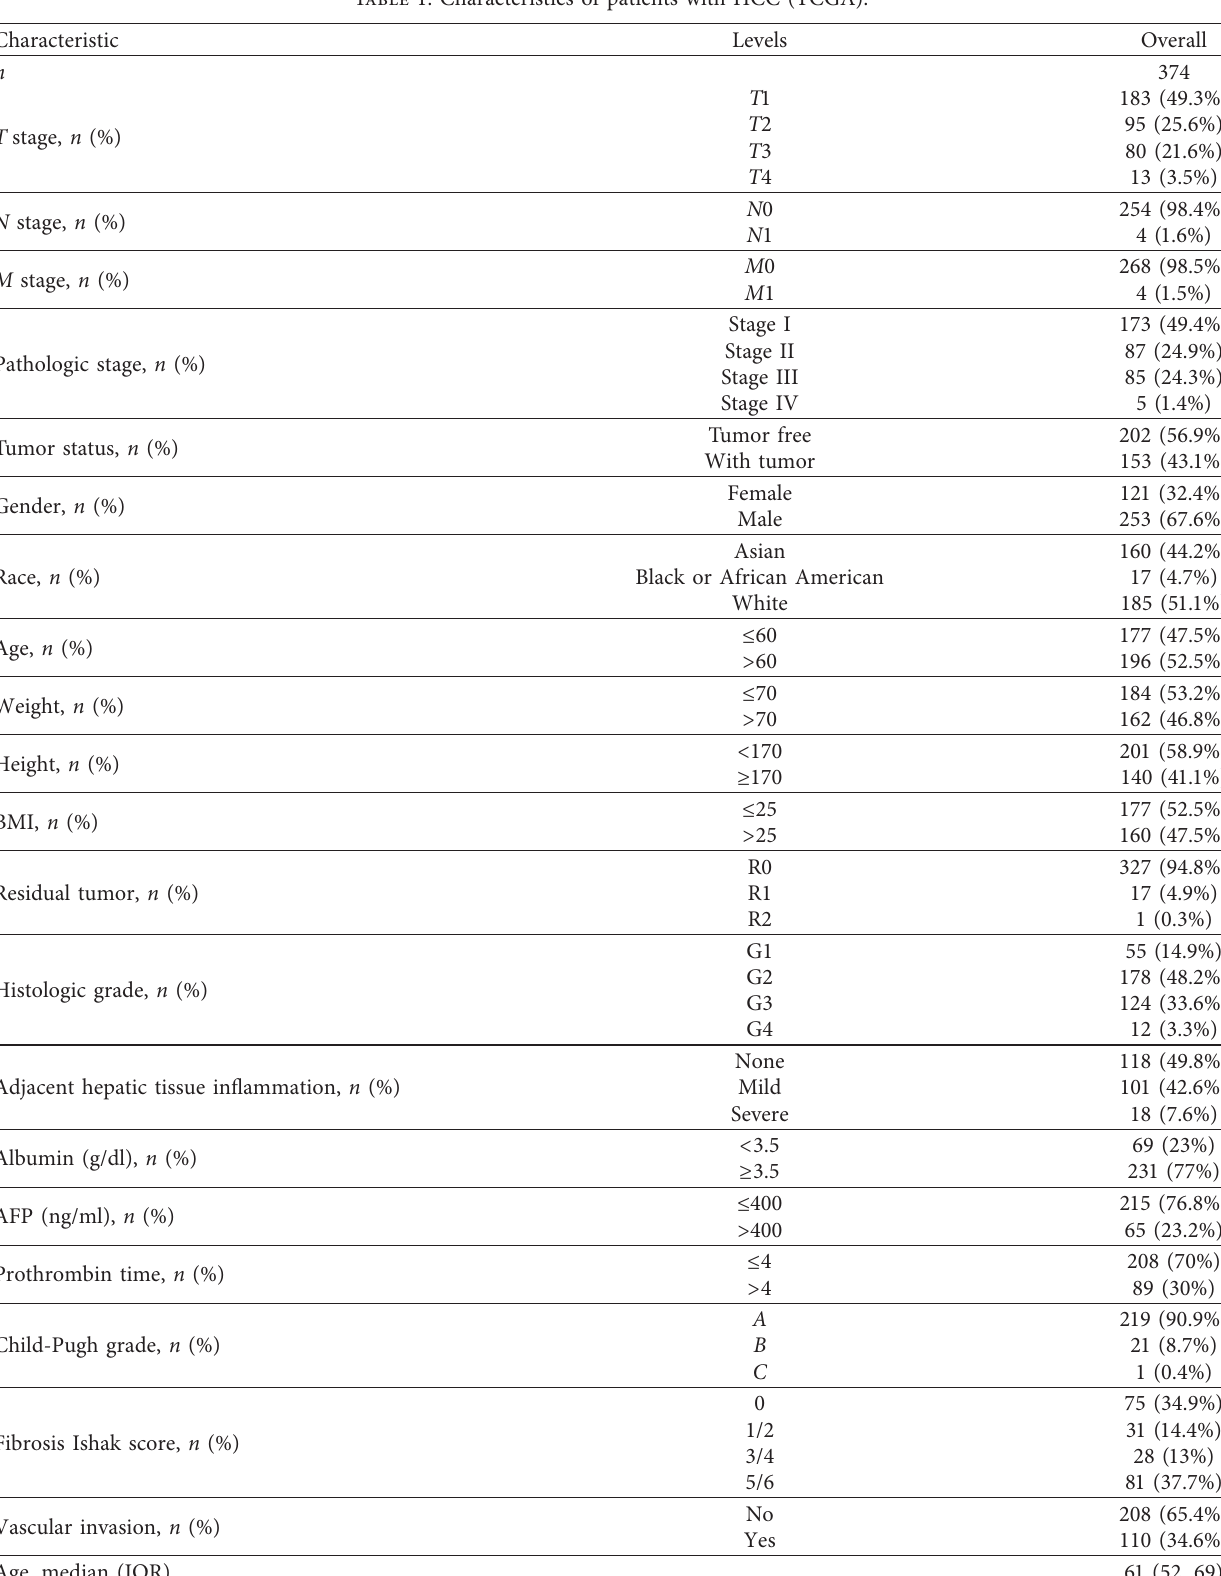
Table 1: Characteristics of patients with HCC